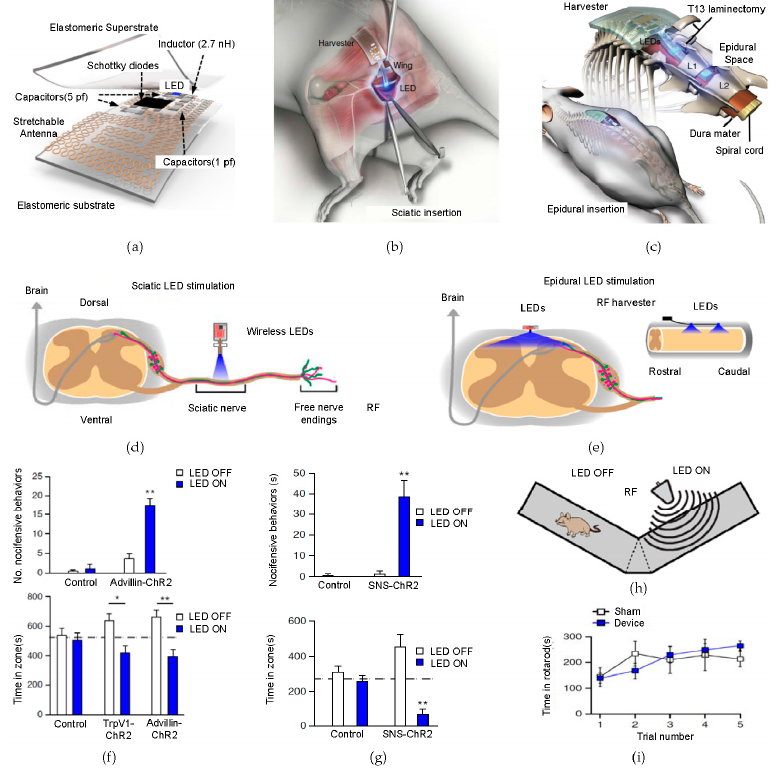
Figure 3. Fully implantable, flexible system for a wireless optogenetic stimulator with related experiments. ( a ) Schematic of a fully implantable, flexible electronic system for a wireless optogenetic stimulator; ( b ) images of the sciatic insertion surgery to implant the completed device into the spinal cord. The wing-shaped light emitting diode (LED) extension site passes from the gluteus maximus to the sciatic nerves; ( c ) a similar implantation is conducted at the epidural space in the spinal cord; ( d , e ) an illustration of the nociception path with an LED stimulator in a sciatic nerve and epidural space; ( f , g ) graphs of number of adverse behaviors/time in y-maze observed by the Advillin-ChR2-treated rodents in accordance with the LED stimulation in the sciatic nerve and epidural space; ( h ) an illustration of the experimental y-maze. Using radio-frequency (RF) signal, pathways are separated by LED on/off environments; ( i ) the graph of a rotarod performance result. This graph shows that motor activity does not change the entire performance of the device. Reproduced with permission from 2015 Nature